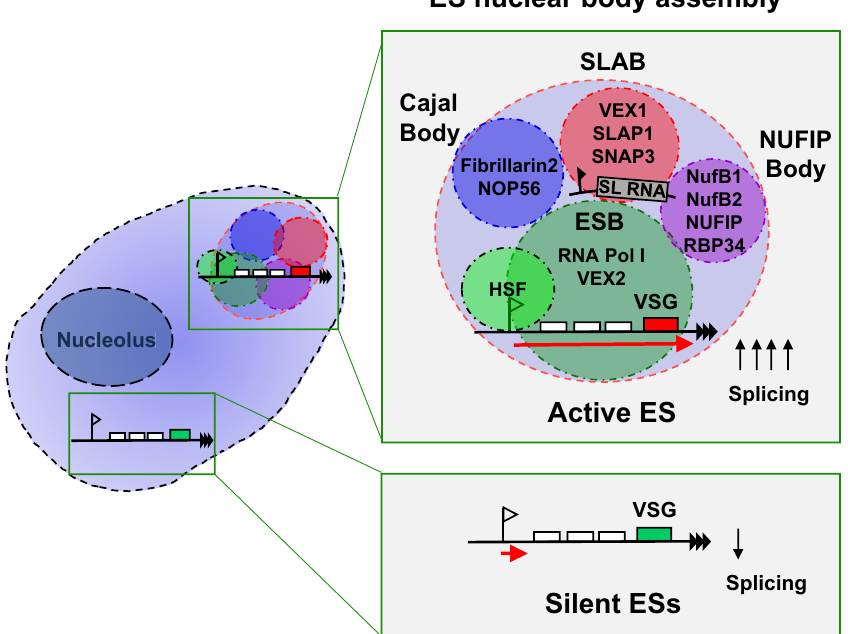
Fig. 10 Model of the architecture of the Expression Site nuclear body assembly in BF T. brucei . Schematic representation of a BF T. brucei nucleus (light blue) with the nucleolus indicated (dark blue). Active and silent ESs are expanded in the green boxes. The active ES is associated with four discrete nuclear bodies: The ESB (green circle), the Cajal body (dark blue circle), the SLAB (red circle) and the NUFIP body (purple circle). The ESB contains Pol I and VEX2, and shows partial overlap with a highly SUMOylated focus (SUMO). The SLAB closely associates with the spliced leader (SL) RNA gene locus. The ESs contain various genes (white boxes) in addition to the telomeric VSG gene, with the promoters indicated with fl ags, transcription with a red arrow and telomere repeats with black triangles. These four nuclear bodies appear to often cluster in a single nuclear compartment which forms an ES nuclear body assembly (large light-blue circle with red dashed outline) satisfying the high demand for splicing at the active ES. Silent ESs are not associated with this ES nuclear body assembly and the low amount of nascent RNA generated from these ESs is not spliced ef fi